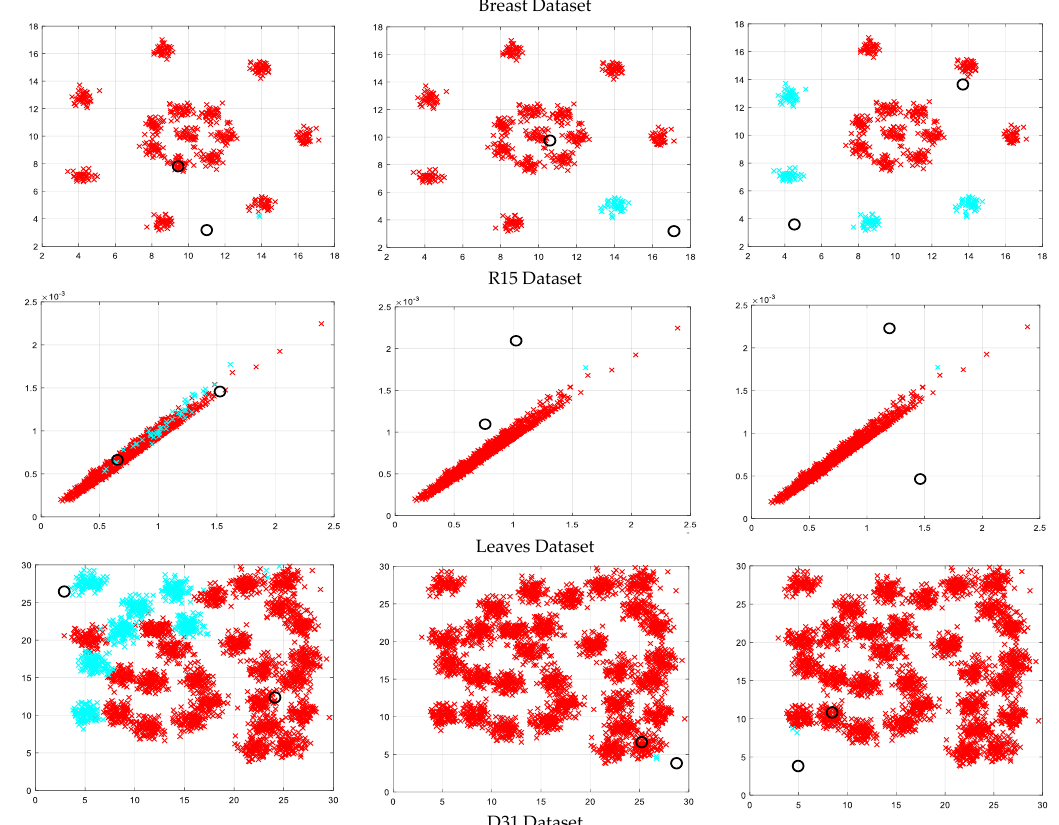
Figure 4. Clustering illustrations for HFAPSO, HCFAPSO and HVSFAPSO clustering algorithms on some selected datasets based on CS index where the black hollow circle represents the number of clusters formed.